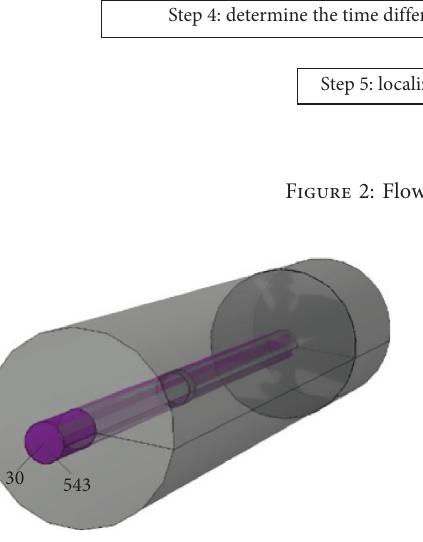
Figure 3: FE model of the damaged pile (purple and grey indicate the pile body and soil, respectively). Table 1: Material properties of the pile and soil.